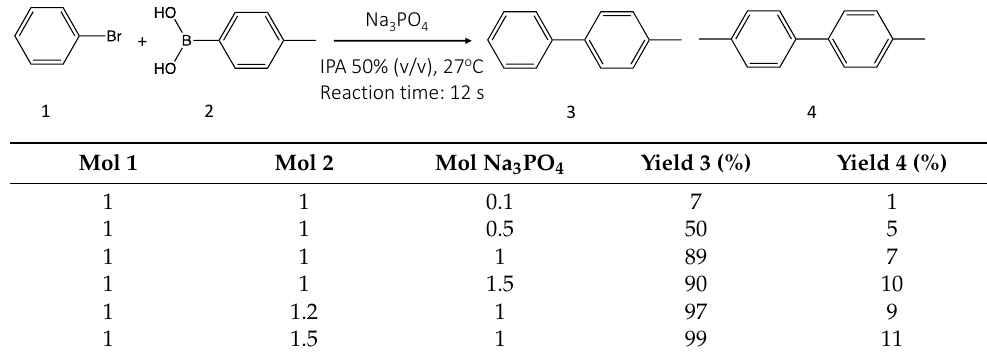
Table Table 2. Optimization of the mole ratio of cross-coupling reagents and base.